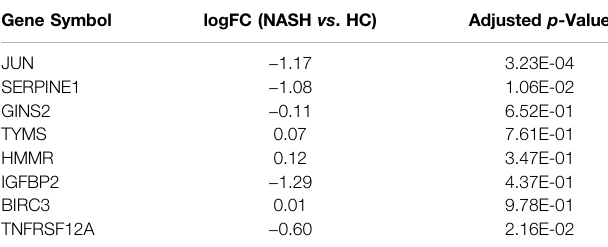
TABLE 4 | Expression pattern of potential hub genes in dataset GSE164760. Gene Symbol logFC (NASH vs . HC)